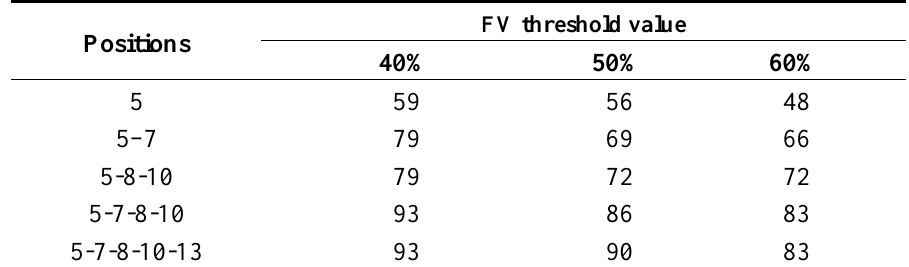
Table 3. FD [%] for different FV threshold values and different number of favourite viewpoints combined from the third